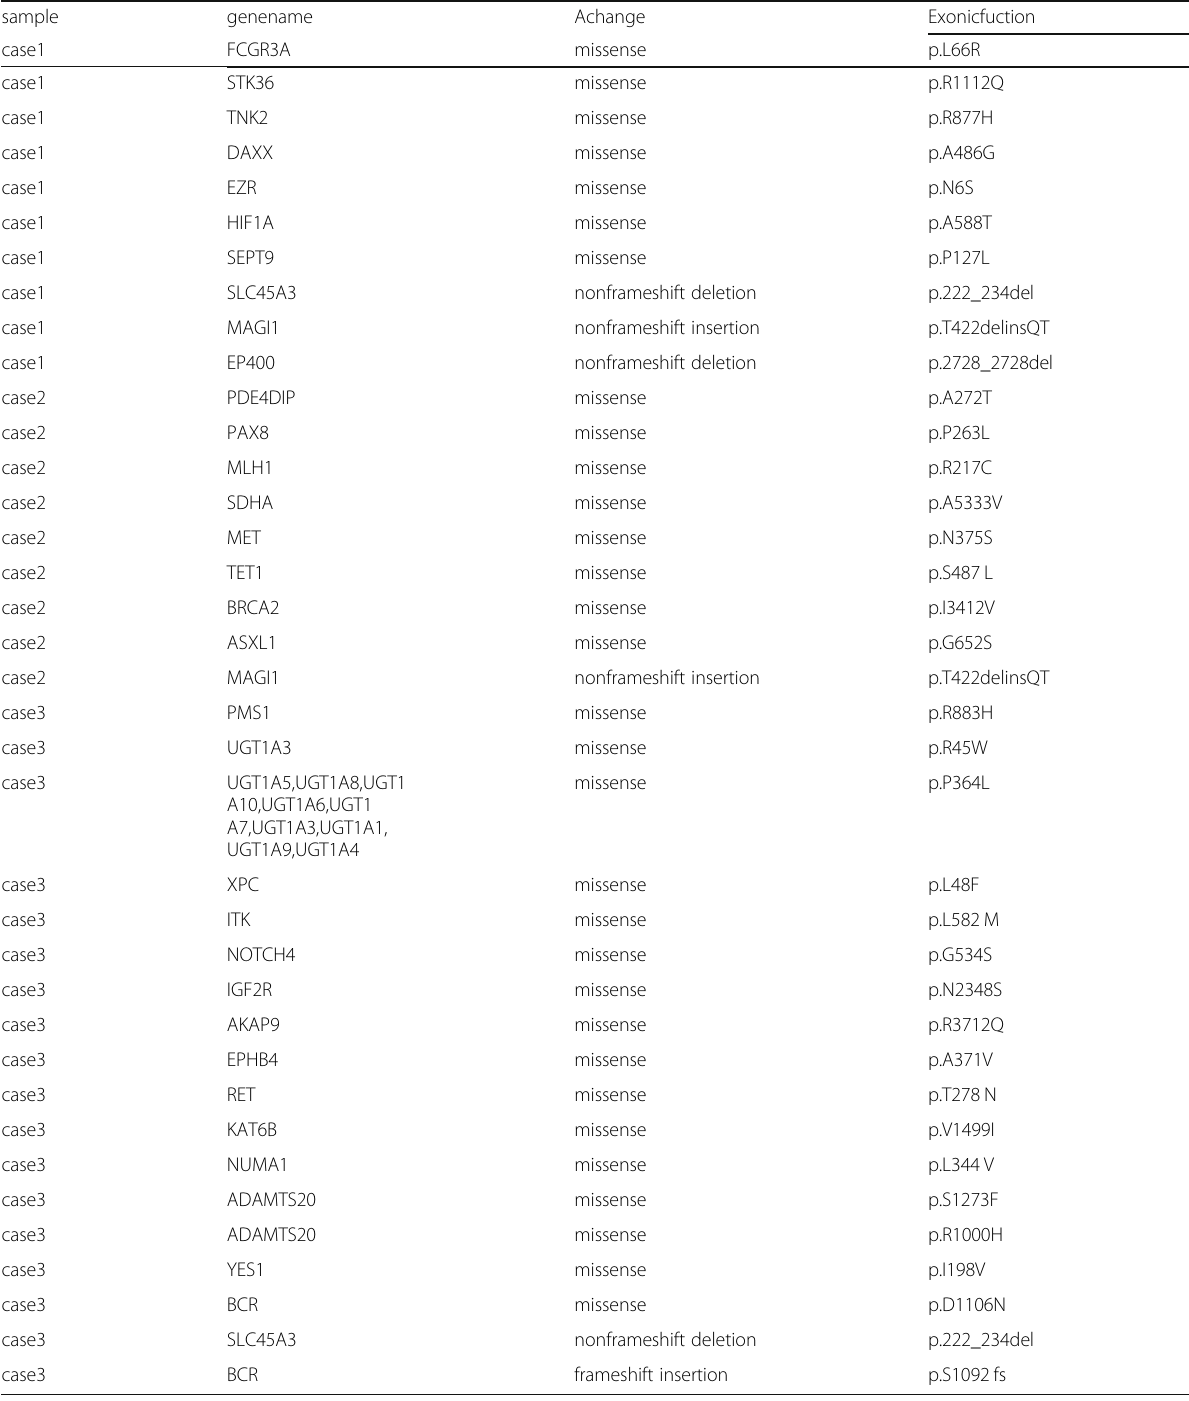
Table 2 The genetic changes of the 3 patients